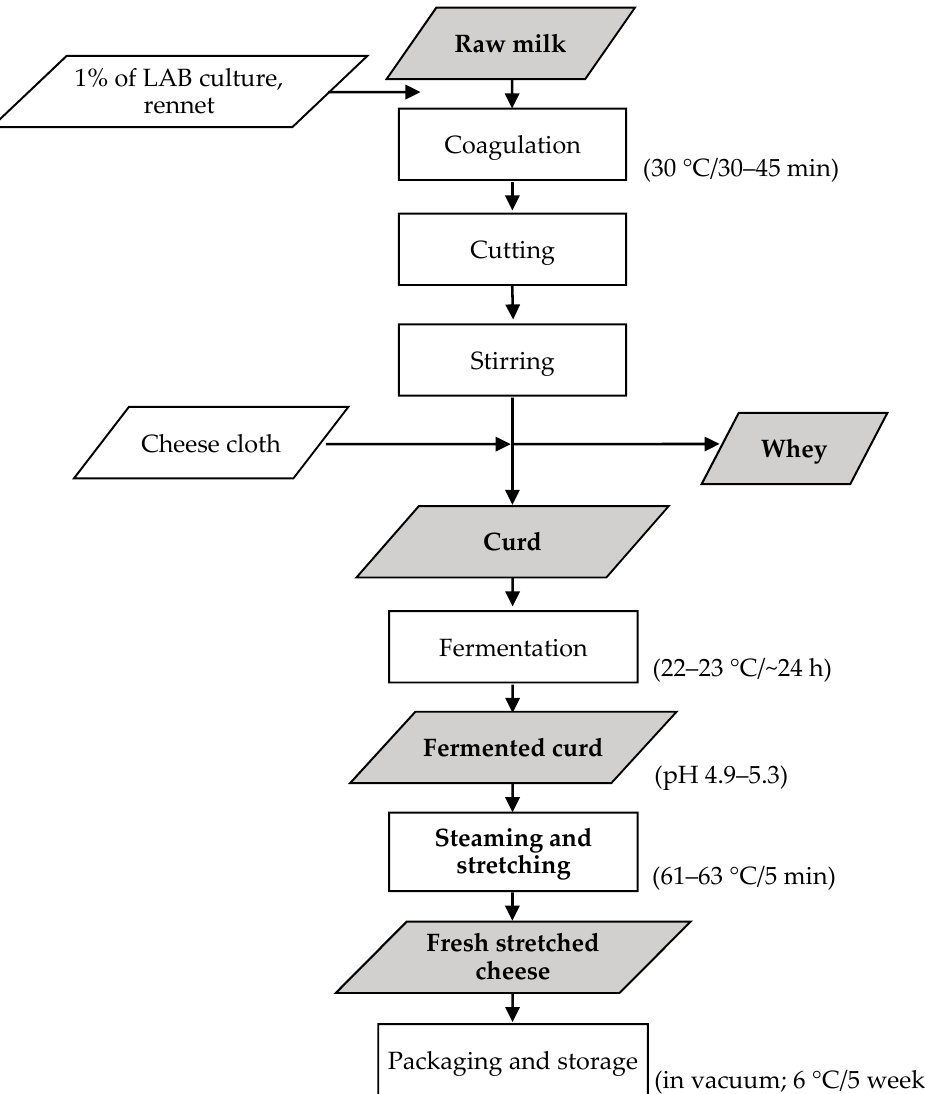
Figure 1. Flow diagram of the artisanal manufacture process applied in the preparation of steamed and stretched cheeses. The Fresco DVS 1010 (Christian Hansen, Hørsholm, Denmark) was used as LAB culture used in this work.